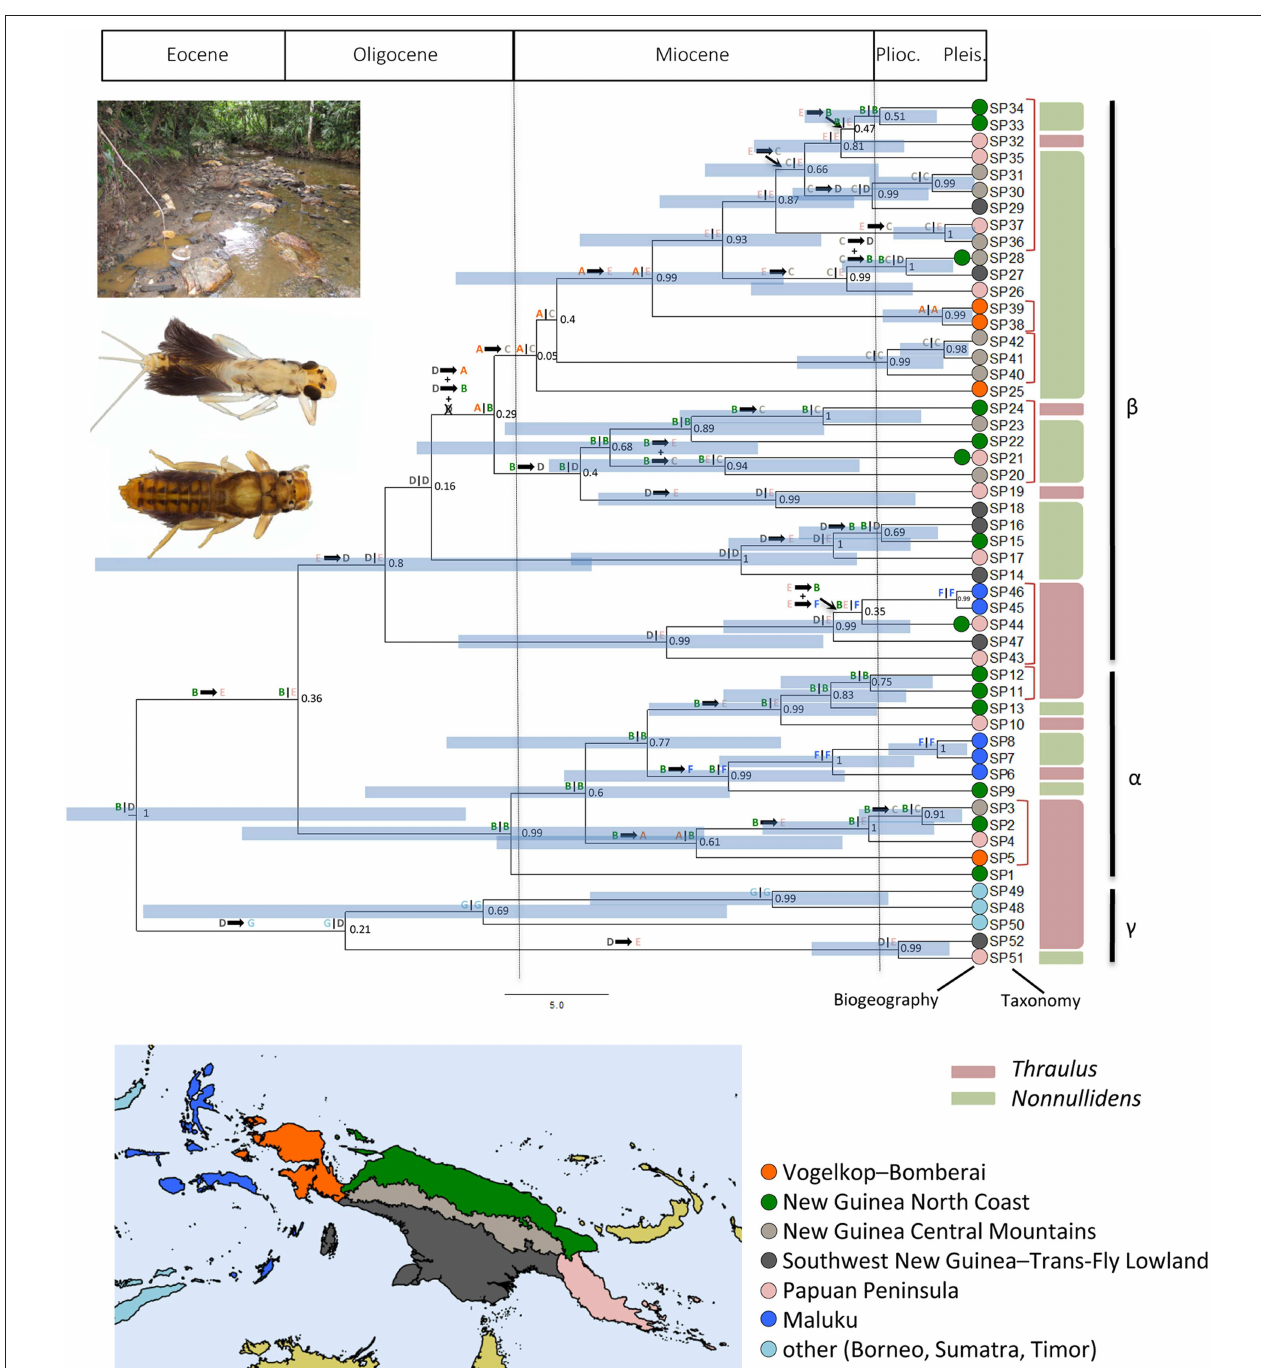
FIGURE 1 | Chronogram of the Thraulus clade as inferred from BEAST v.1.8.3 (Drummond et al., 2012), after pruning the outgroups, with Bayesian Posterior Probabilities (BPPs) indicated at each node. Tips show lineages associated with OTUs as inferred from bPTP analyses (Zhang et al., 2013). Tips clustered by red brackets are lineages that were grouped into OTUs by the mPTP analyses (Kapli et al., 2017). Current taxonomic assignment to genera is indicated using a color frame on the right of the tree. Time is shown along the X-axis (with an indication of geological eras at the top of the figure). On each branch are shown dispersal events among biogeographic areas as inferred from the Bayesian Binary MCMC analysis (Yu et al., 2015). Above each node is shown the geographical context of lineage divergence (either in vicariance or within the same area). Blue rectangles over nodes represent 95% HPD ranges (values given only for nodes with BPP > 0.5). Colors shown at the tips of the tree represent the geographic area(s) corresponding to freshwater ecoregions of New Guinea following Abell et al. (2008), where the lineages are found. Areas are illustrated below on a map, created using the software QGIS (QGIS Development Team, 2009). Major clades are shown with vertical bars on the right of the